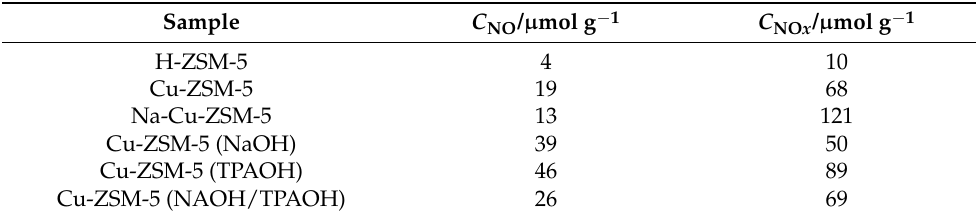
Figure 6. ( a ) TPD-NO x (desorption of NO and NO x ) profiles and ( b ) TPD-NO x (desorption of NO x ) profiles (solid measured, dashed modeled) of H-ZSM-5 and micro-/mesoporous Cu-exchanged ZSM-5 and Cu-exchanged ZSM-5 with co-cation, carried out in the flow of (4 vol.%) O 2 /He mixture. Table 4. NO x adsorption capacity of H-ZSM-5 and Cu-exchanged ZSM-5 carried out in the flow of (4 vol.%) O 2 /He mixture (data corresponding to results shown on Figure